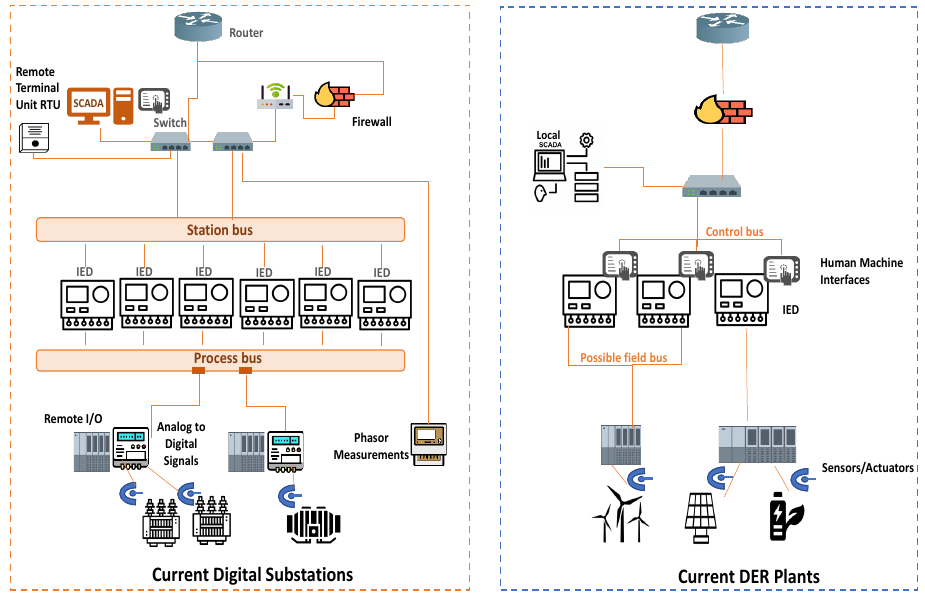
Figure 2. Current Digital Substation and DER Plant architectures based on